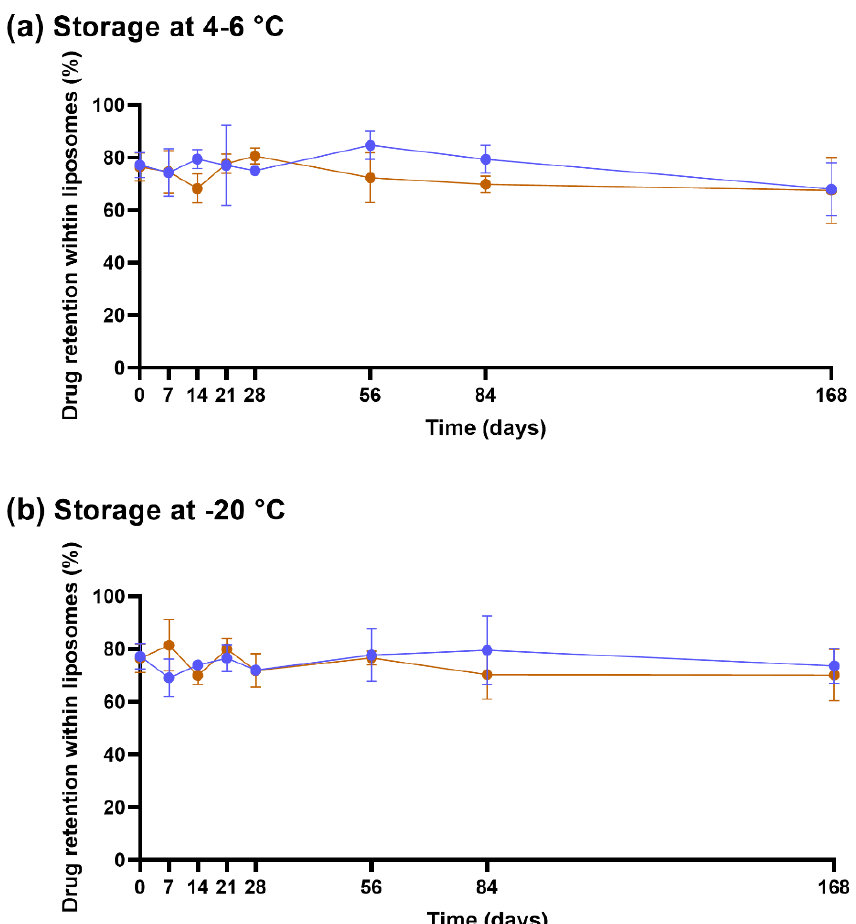
Figure 3. Retention of Cu 2+ in Cu 2+ -liposomes (blue) and Cu(DDC) 2 in Cu(DDC) 2 -liposomes (brown) following storage of the lyophilized liposomes at 4–6 ◦ C or − 20 ◦ C. Aliquots of lyophilized Cu 2+ - liposomes and Cu(DDC) 2 -liposomes were stored at ( a ) 4–6 ◦ C or ( b ) − 20 ◦ C for up to 168 days. Cu 2+ - liposomes and Cu(DDC) 2 -liposomes were resuspended and filtered after predetermined storage times. Cu 2+ concentrations of Cu 2+ -liposomes and Cu(DDC) 2 -liposomes were determined before and after the filtration step. A reduction in Cu 2+ concentration indicated Cu 2+ or Cu(DDC) 2 leakage from liposomes. Data are expressed as the mean ± standard deviation (n = 3).